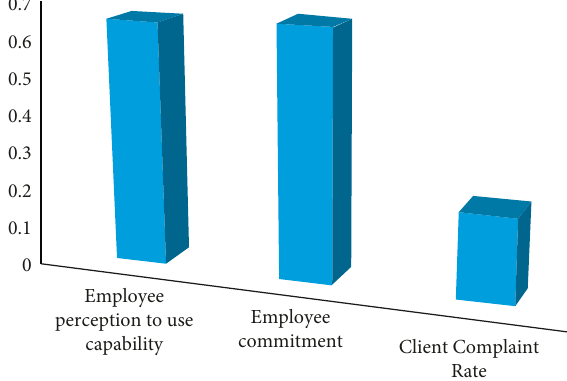
Figure 3: Weight of criteria in the customer perspective.